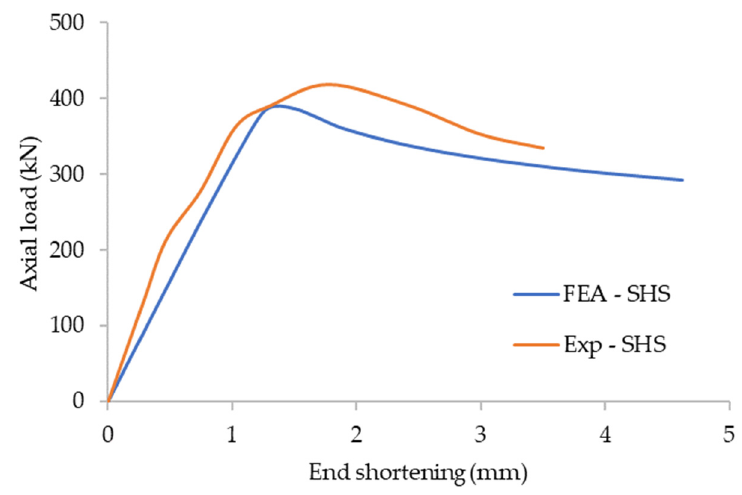
Figure 5. Experimental [17] and FE axial load-end shortening